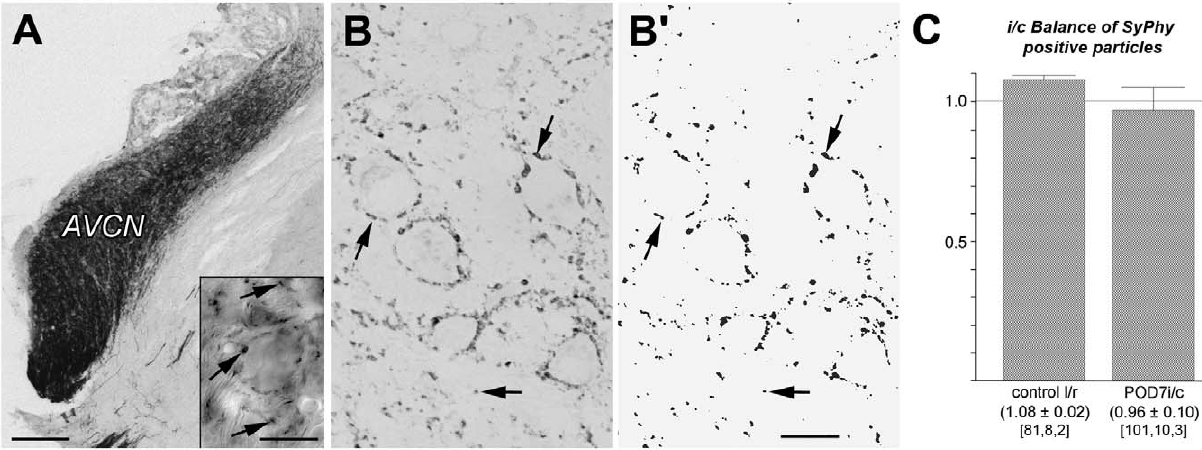
Figure 1. Anterograde tracing and SyPhy immunoreactivity in AVCN. (A) Anterograde axonal tracing with BDA from cochlea to AVCN, resulting in a great number of fiber segments and presynaptic endings darkly labeled (inset, arrows). Scale bar =200 m m, 20 m m for inset. (B) Pattern of SyPhy immunoreactivity and (B’) rendering of staining for computer-based image analysis and counting of stained subcellular structures qualified by size and distribution to be presynaptic boutons (arrows). Scale bar =20 m m. (C) As must be expected, the number of such boutons is balanced between left and right side (control rat l/r) in normal hearing animals (left). Surprisingly, the balance persisted between ablated and unaffected side (right) by POD7, suggesting that SyPhy immunoreactivity does not reflect deafferentation-dependent changes taking place in the cochlear nucleus. Numeric triplets below columns indicate numbers of fields analyzed, tissue probes (embedded sections), and brains, respectively, on which statistical analysis is based.